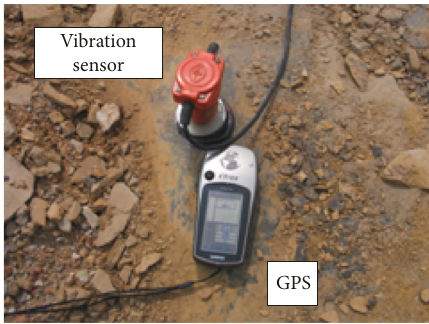
Figure 5: Vibration sensor and